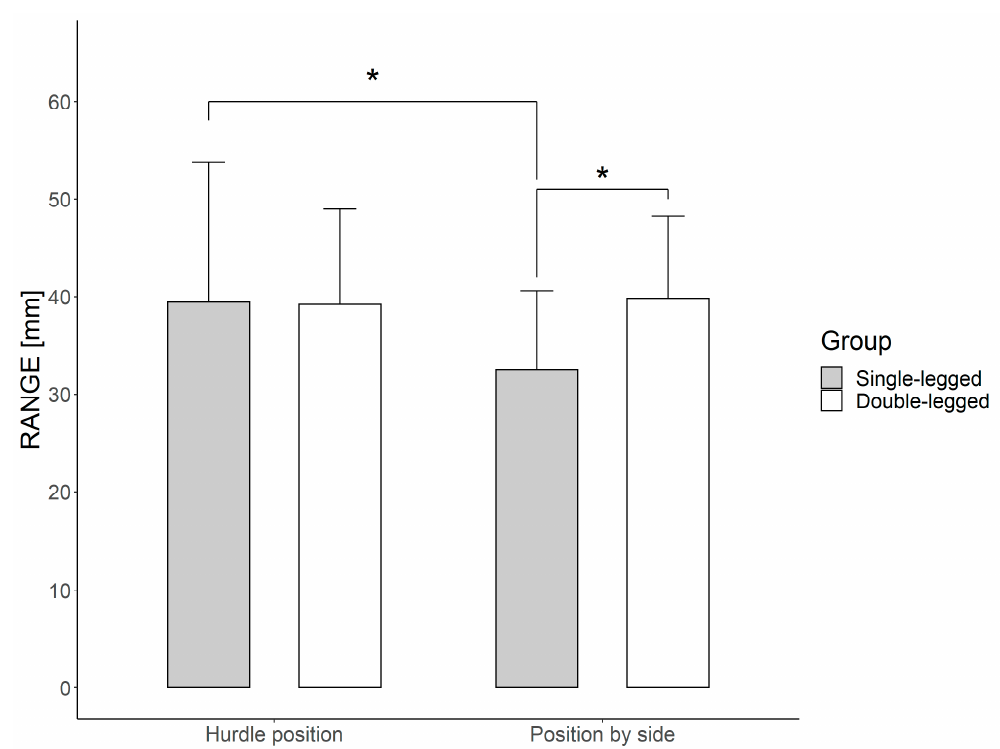
Figure 3. Range (RA) differences (mm) in the anterior–posterior (AP) direction between subjects in the single-legged and double-legged groups ( p < 0.01) in the one-legged position “b” and under the upper limb condition H2; RA differences (mm) in the AP direction between the upper limb conditions H1 and H2 in group A1 in position “b” ( p < 0.01). * p < 0.01. Table 2. Descriptive statistics for the total sample.